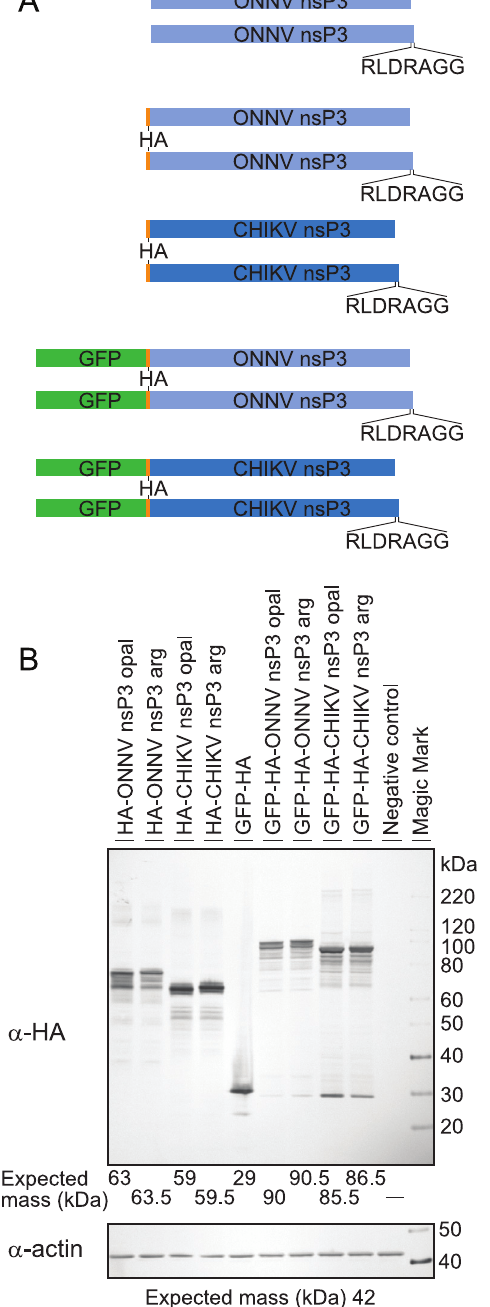
Fig 2. Expression of recombinant nsP3s in Sua 4.0 cells. (A) Diagrams of the protein gene cassettes used in this study that were expressed in anopheline cells. N-terminal variants were made with only the required start methionine, an HA-tag, or a GFP-HA tag. Two different C-termini were made. The shorter variants contain an opal stop codon. The longer variants have the opal codon replaced with arginine and encode seven additional amino acids to the protease cleavage site, where nsP3 is cleaved from nsP4. Recombinant nsP3 has a stop codon at the cleavage site. (B) Western blot against the HA-tag showing the alphavirus nsP3s expressed in Sua 4.0 cells. Actin was used as a loading control. The negative control cells did not have any plasmid DNA